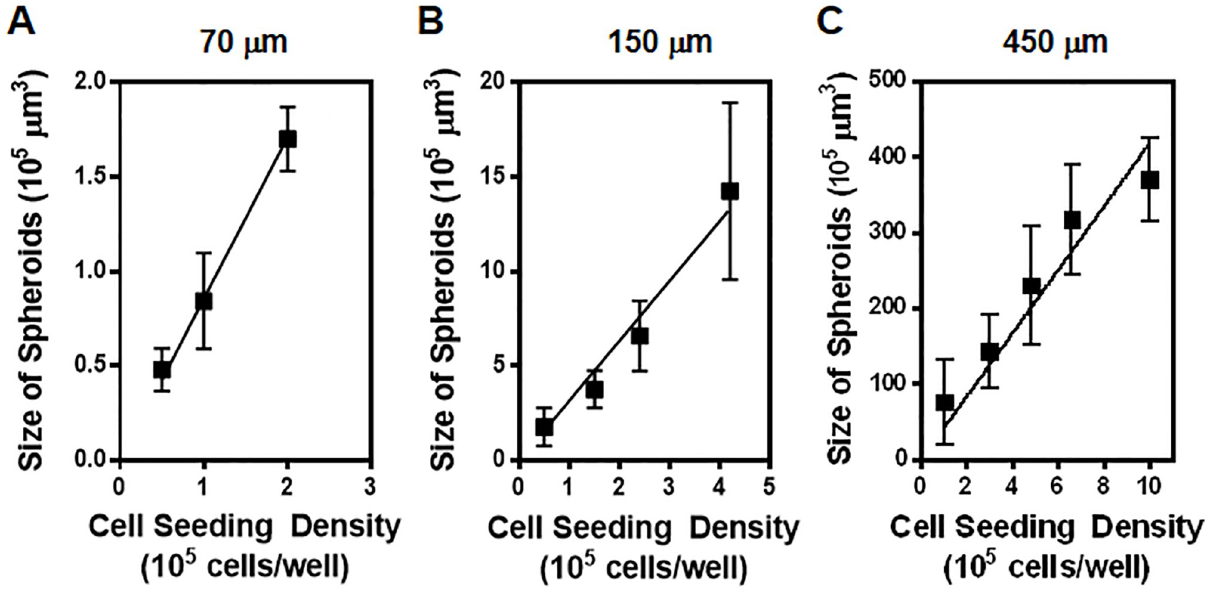
Fig 4. Effect of initial cell seeding density and hydrogel microwell size on the final size of U251 glioma spheroids. Graphs show the volume of U251 spheroids, measured after 2 days in culture as a function of cell seeding density per well of the culture plate that contained agarose microwells with diameters of 70 μ m (A), 150 μ m (B), and 450 μ m (C). Data points represent the mean of 10 independent experiments and error bars represent standard deviation (SD). Solid lines show the linear fit to the data.